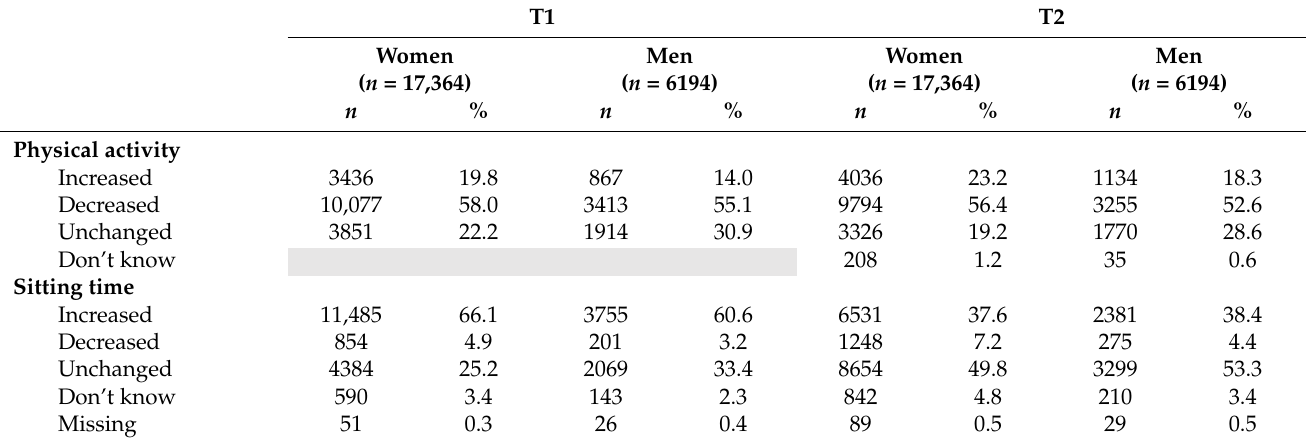
Table 2. Physical activity and sitting time changes during the lockdown reported by participants according to